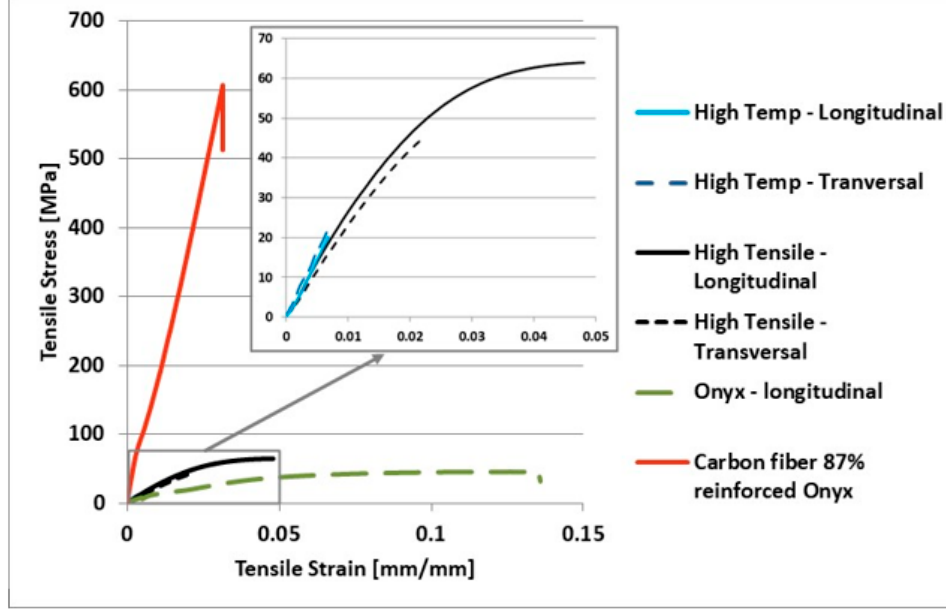
Figure 12. Stress–strain curves in the tensile test. Table 6. Maximum tensile strength